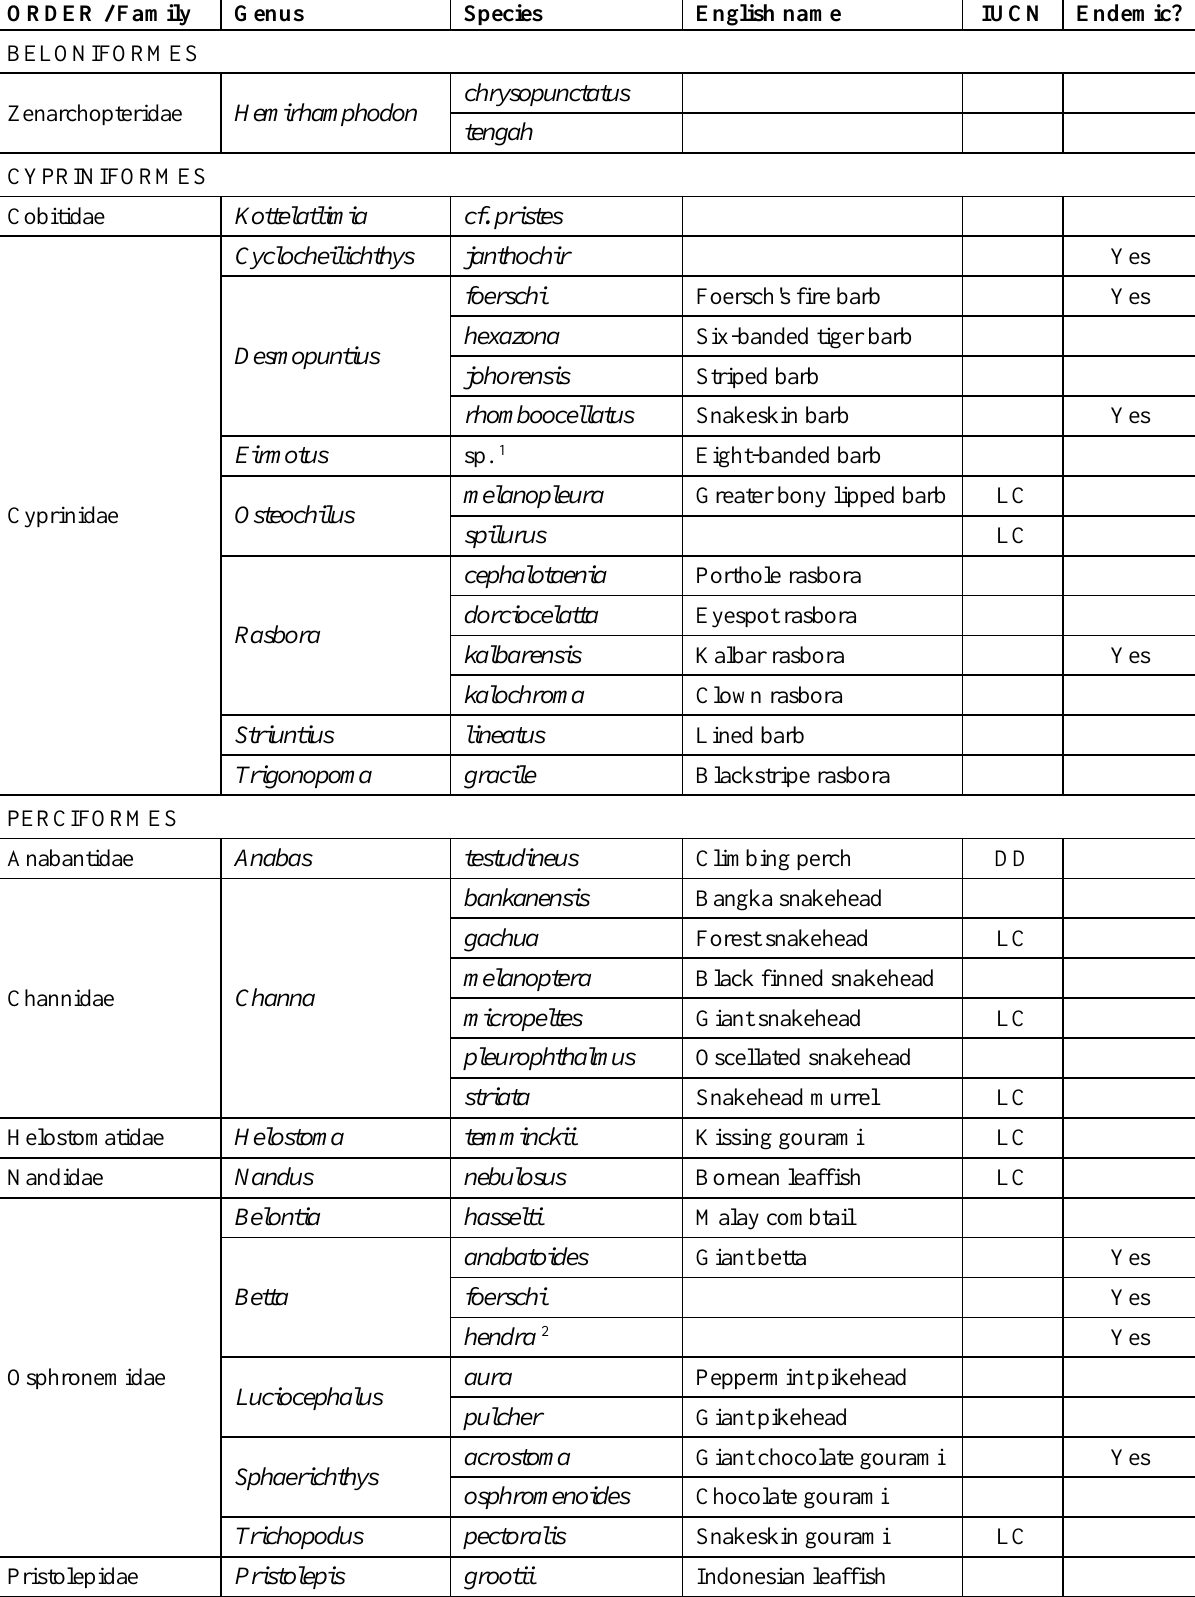
Table A6. List of freshwater fish (Actinopterygii) species recorded in the NLPSF, Sebangau, together with IUCN Red List classifications (DD = data deficient; LC = least concern; VU = vulnerable) and Borneo endemic species assignments. None of these species are included in the Indonesian protected species list. Additional local and Indonesian species names are provided by Thornton